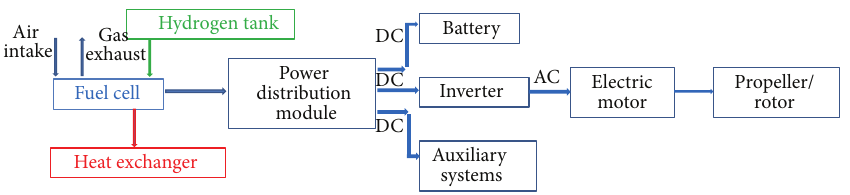
Figure 2: Diagram of the elements of a propulsion system with a mechanical energy converter based on a fuel cell + electric motor combination [5] (adapted from [6]).